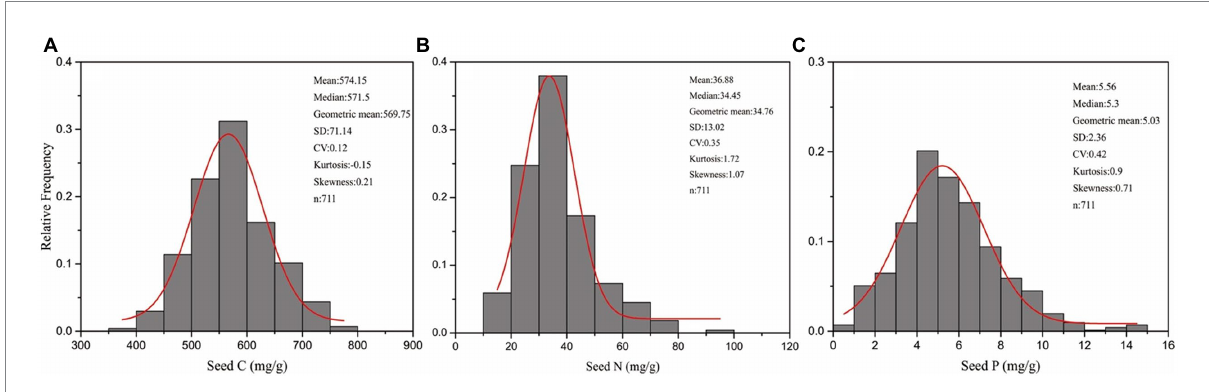
FIGURE 2 Frequency distribution of seed carbon (C) (A) , nitrogen (N) (B) and phosphorus (P) concentrations (C) for all 253 herbaceous species on the eastern Tibetan